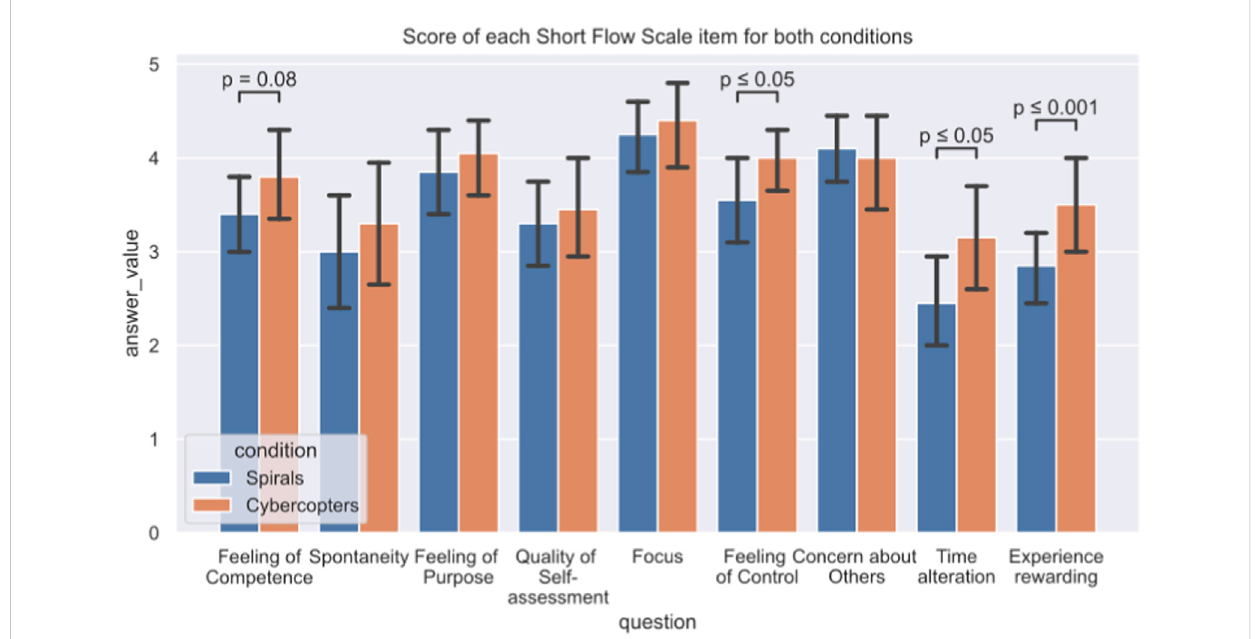
FIGURE 11 Detailed answers to the Short FLOW Scale for both interfaces. There are signi fi cant differences in questions about feelings of competence, the controls, time distortion, and how rewarding participants found the